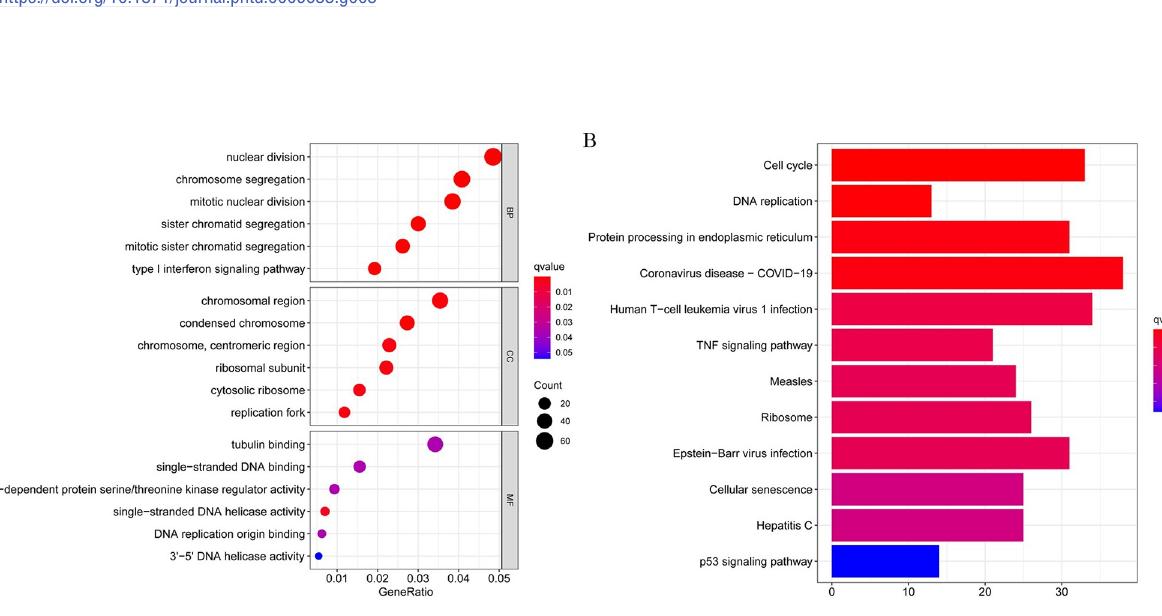
PLOS NeglectedTropical Diseases | https://doi.org/10.1371/journal.pntd.0009633 August 4, 2021 8 /